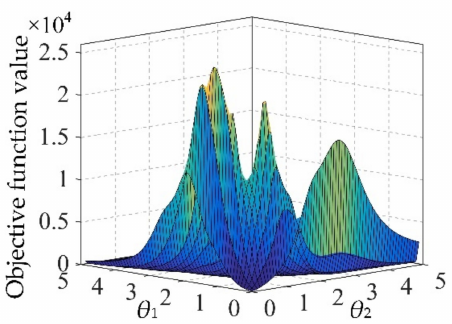
Figure 1. Multi-modality characteristics in Kriging